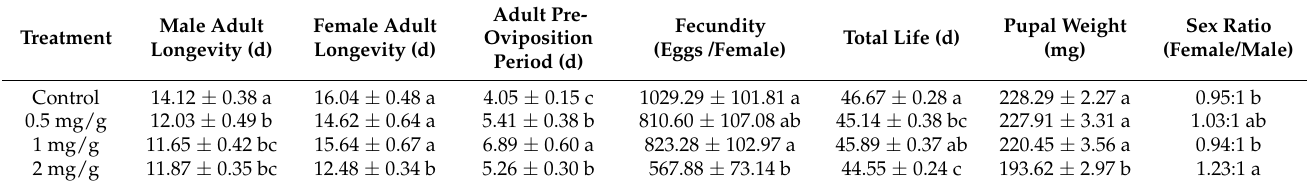
Table 4. Differences in the pre-oviposition period, female egg production, pupal weights, female-to- male ratios, and lifespan of Spodoptera frugiperda